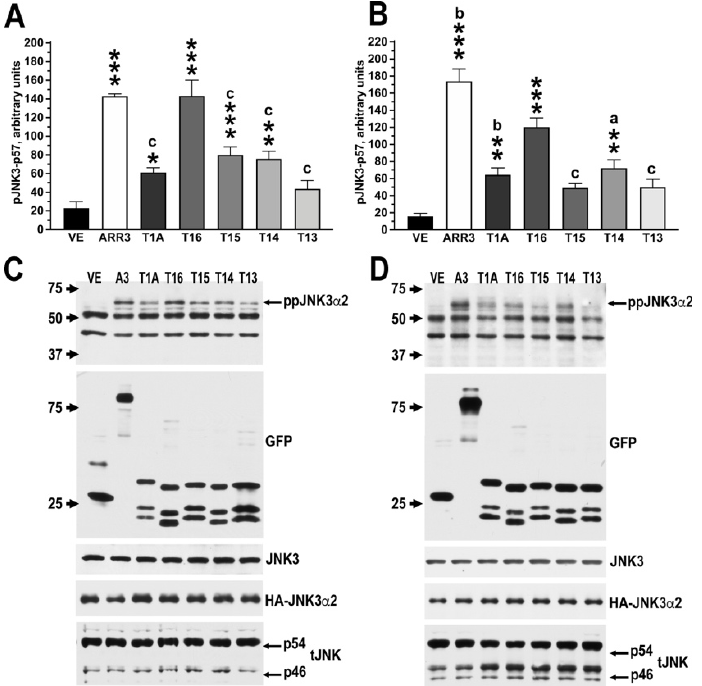
Figure 6. In cell JNK3 activation. ( A , B ) Quantification of the Western blot data of the peptide-induced JNK3 activation in HEK293 ( A ) or HEK293 arrestin-2/3 knockout (DKO) ( B ) cells. ( C , D ) Corresponding representative Western blots for phospho-JNK, total JNK, JNK3, HA, and GFP are shown for WT ( C ) and DKO ( D ) cells. The cells were transfected with HA- JNK3 α 2 (which is easy to detect because it runs higher than all isoforms of endogenous JNK1 and JNK2) and indicated Venus fusion of full-length arrestin-3 or peptide constructs. At 48 h post-transfection, the cells were lysed, the lysates processed and subjected to the Western blot analysis described in Methods. The band corresponding to the doubly phosphorylated ppJNK3 α 2 (indicated by arrows in ( C , D )) was quantified by densitometry using Quantity One software. Westerns were used to demonstrate equal expression of HA-JNK3 α 2 using HA, total JNK, and JNK3 antibodies. Note that the total JNK antibody detects p54 and p46 bands, which contain eight JNK1/2 isoforms present in most cells [32], but does not detect the longer JNK3 α 2 isoform. All Venus fusions were detected with an anti-GFP antibody to compare the expression of different constructs. The Venus peptides run slightly above the Venus band; multiple lower molecular weight bands result from in-cell proteolysis. Statistical analysis was performed using Prizm9 software. The data were analyzed by one-way ANOVA followed by Dunnett’s post hoc test to compare all constructs with the Venus control. To compare the activity of T16 with other constructs, we used the Bonferroni post hoc test with correction for multiple comparisons. N = 5–7. *, p < 0.05; **, p < 0.01; ***, p < 0.001 to the Venus values; a— p < 0.05, b— p < 0.01, c— p < 0.001 to the T16